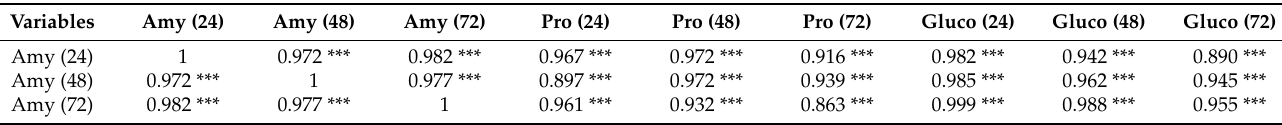
Table 4. Spearman’s correlation coefficients for different seed germination attributes of safflower treated with different laser